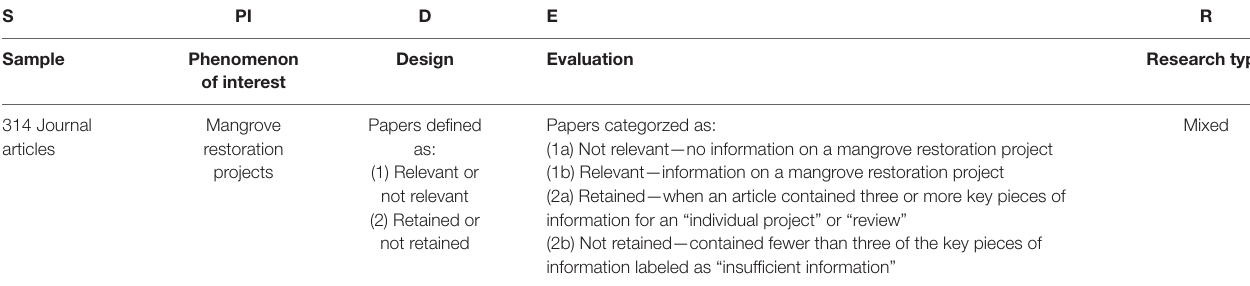
TABLE 3 | SPIDER protocol applied for inclusion/exclusion based on article full text (Cooke et al., 2012). S PI D E